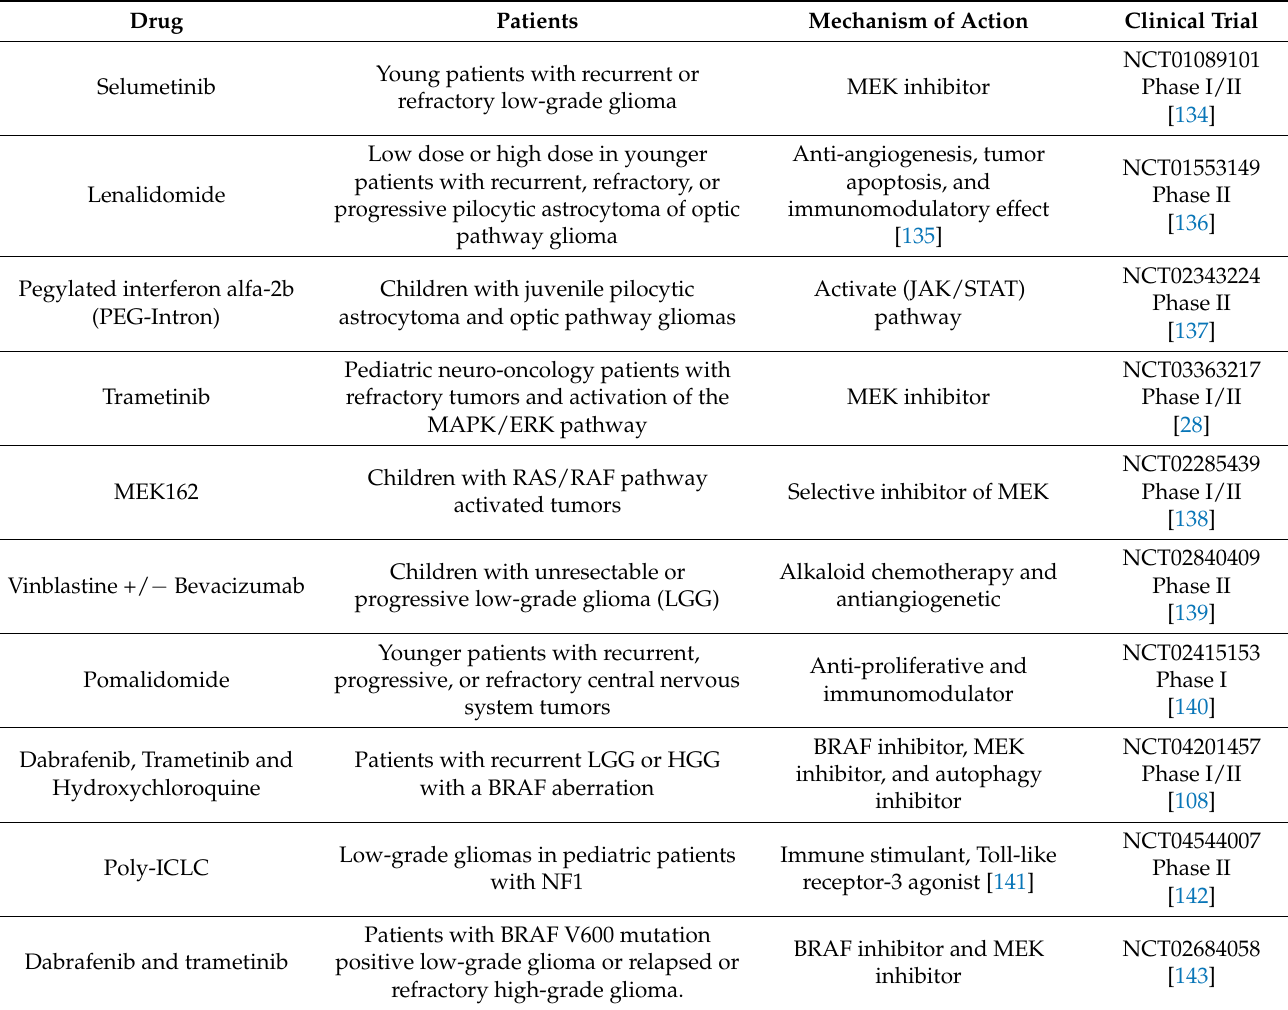
Table 1. Ongoing clinical trial for drugs in NF1